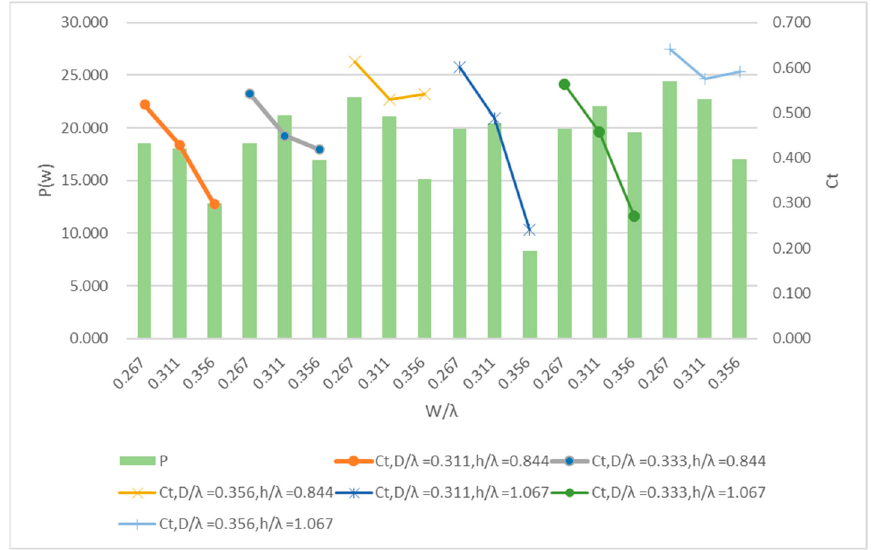
Figure 17. Physical experiment data map. Figure 17. Plot of experimental data with W/ λ as